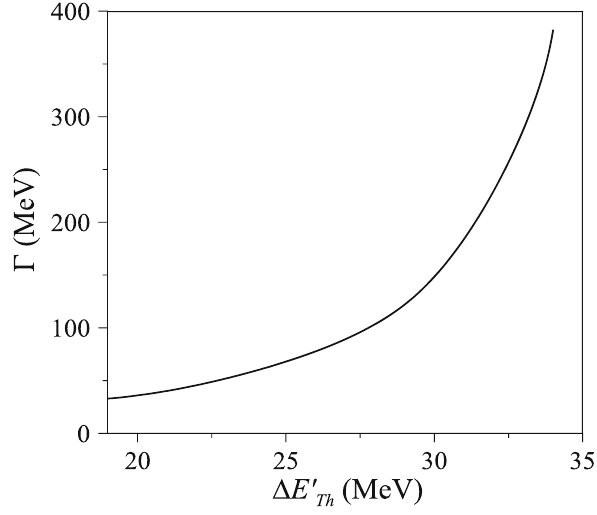
Fig. 3 Widthoftheresonance, (cid:3) ,asafunctionoftheenergydifference between its mass and the mass of the upper threshold generating the = m + m − W state, (cid:4) E (cid:2) R , for a fixed energy with respect to the 3 4 Th lower threshold, (cid:4) E Th = W R − m 1 − m 2 = 6.5